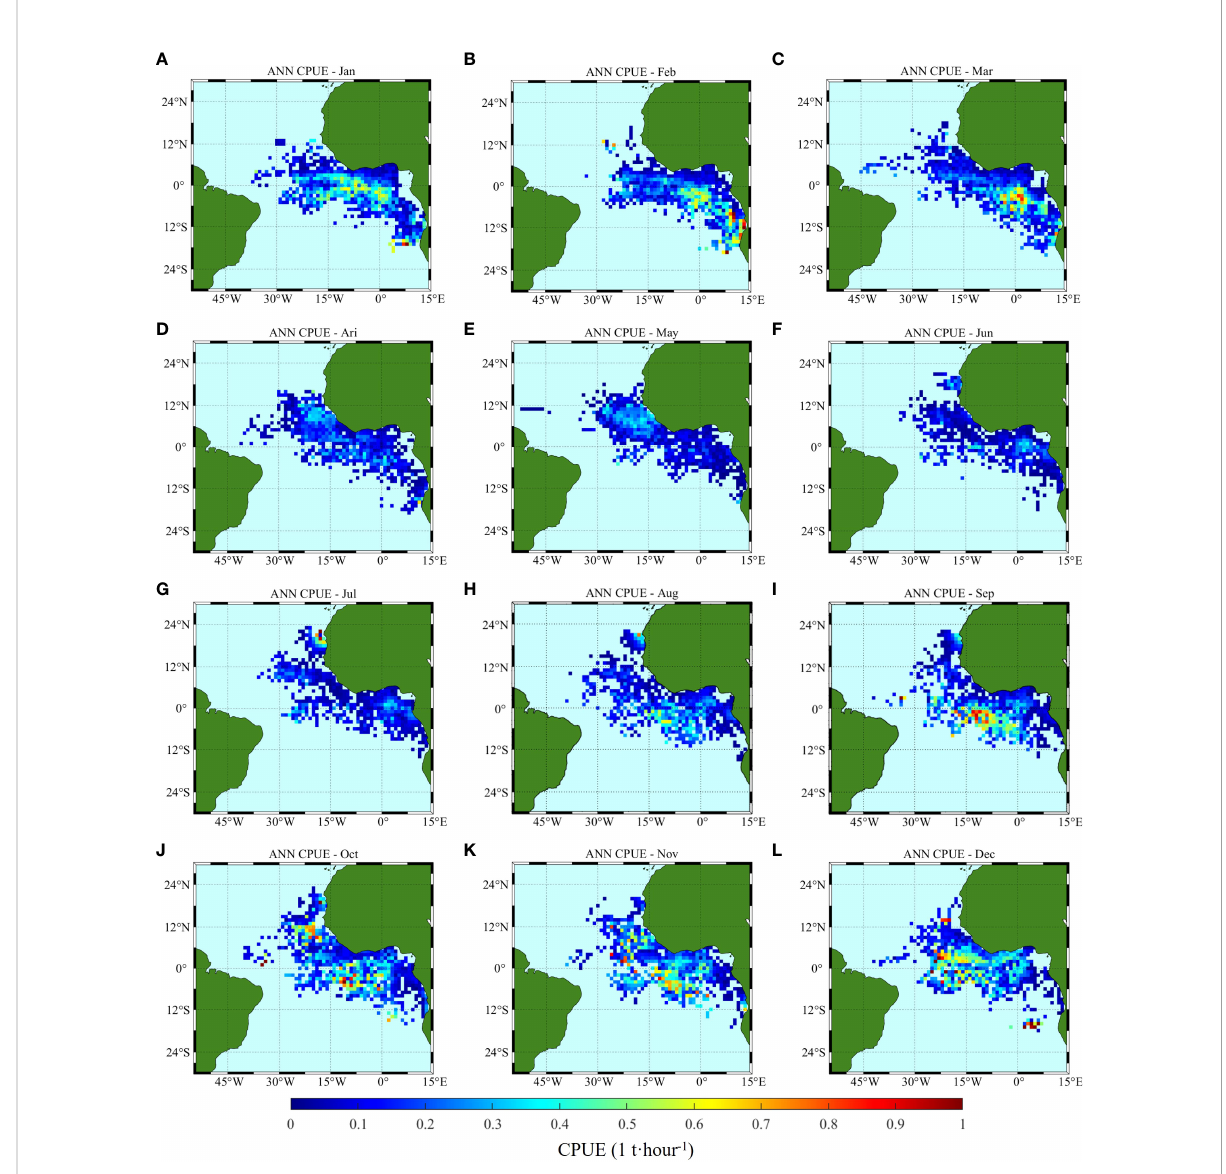
FIGURE 8 Climatology monthly spatial distribution of CPUE predicted by ANN, (A – L) correspond to January to December,